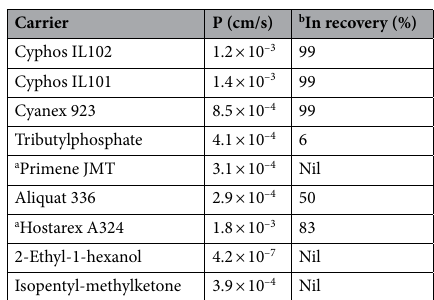
Table 3. Results of In(III) transport and metal recoveries in the receiving phase using different carriers. a Acting as the corresponding quaternary ammonium salt. b After 3 h, and with respect to the metal transported from the source to the membrane